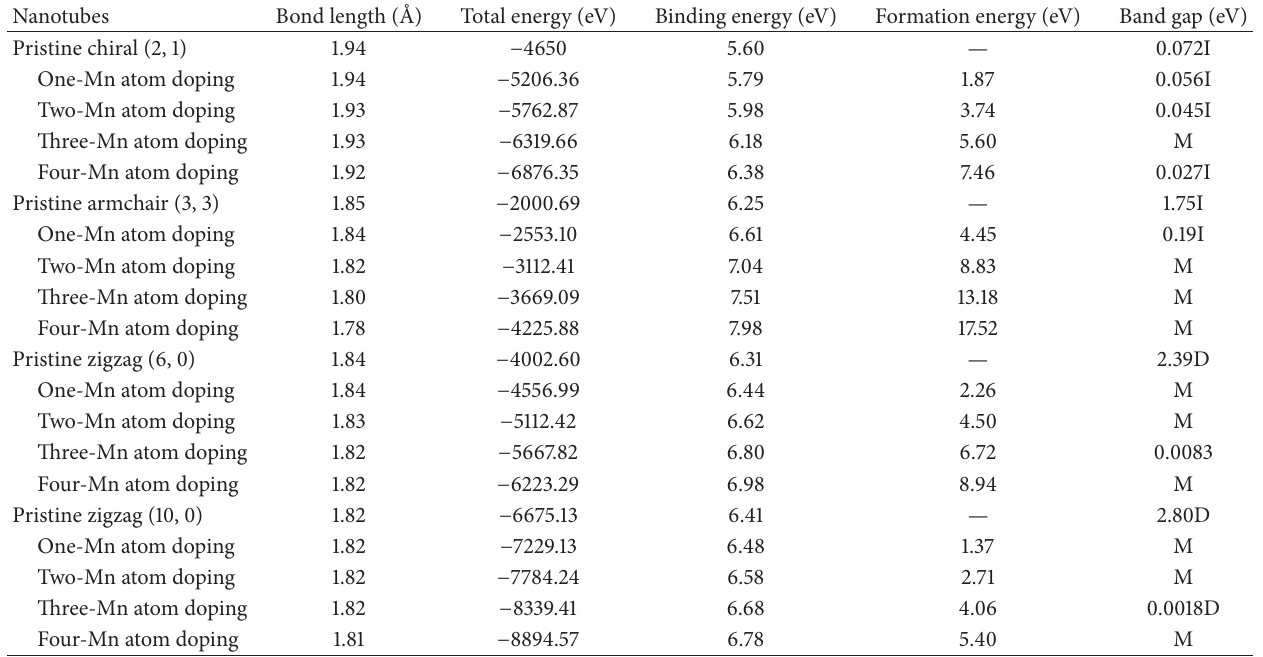
Table 1: The bond length, binding energy, formation energy, and bandgaps of different types of doped and undoped single walled GaN nanotubes.